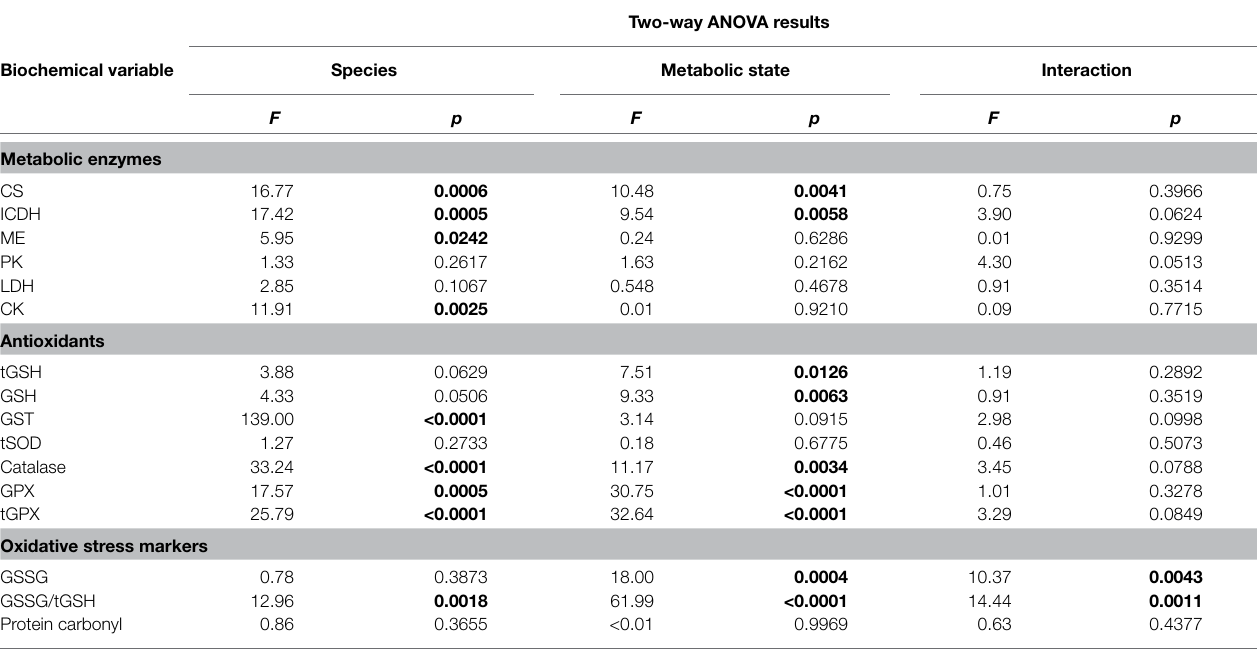
TABLE 2 | Two-way ANOVA of the biochemical variables measured in the skeletal muscle of free-ranging Pleurodema diplolister and Proceratophrys cristiceps collected during the rainy (active) and the dry season (estivating) in the Caatinga.